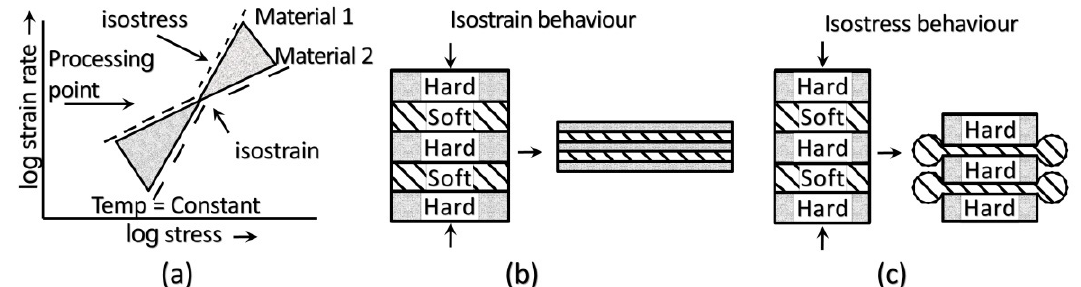
Figure 8. Deformation response of bimetallic materials during equiaxed compression: ( a ) strain rate- stress response, ( b ) isostrain behavior, and ( c ) isostress behavior (Reprinted with permission from Ref. [40], image on page 172. 1996, Taylor and Francis).